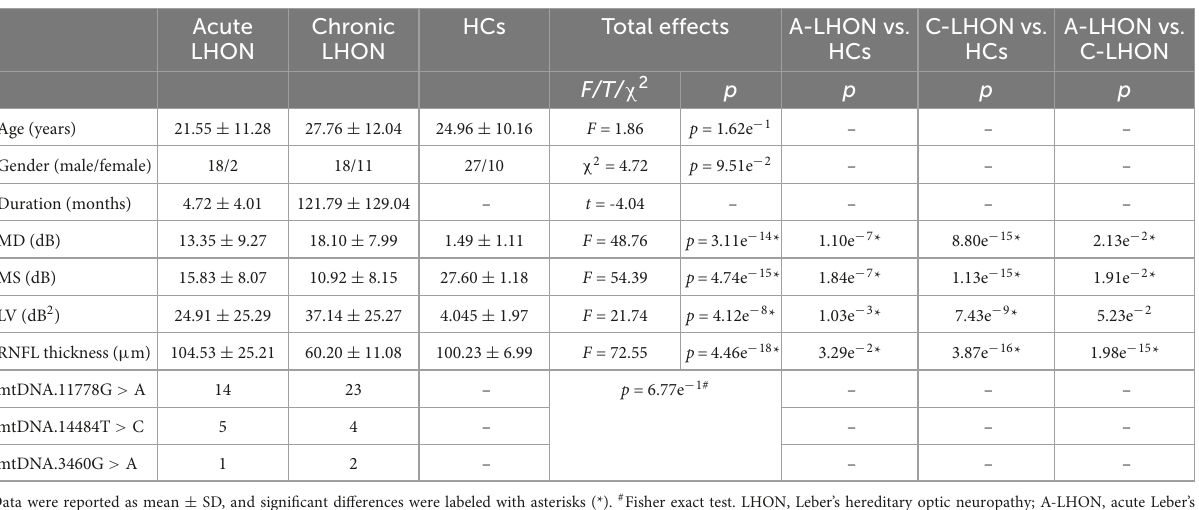
TABLE 1 Demographic and clinical characteristics of this study.